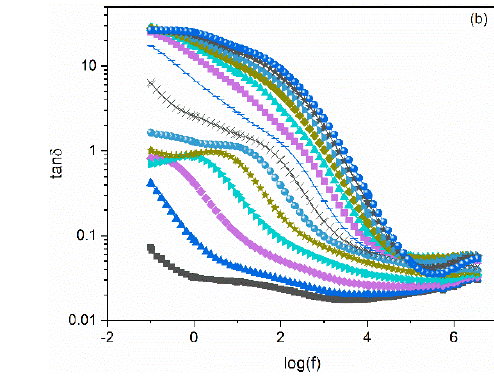
Figure 5. Imaginary part of electric modulus ( a ) and loss tangent ( b ) versus frequency for the 10 phr